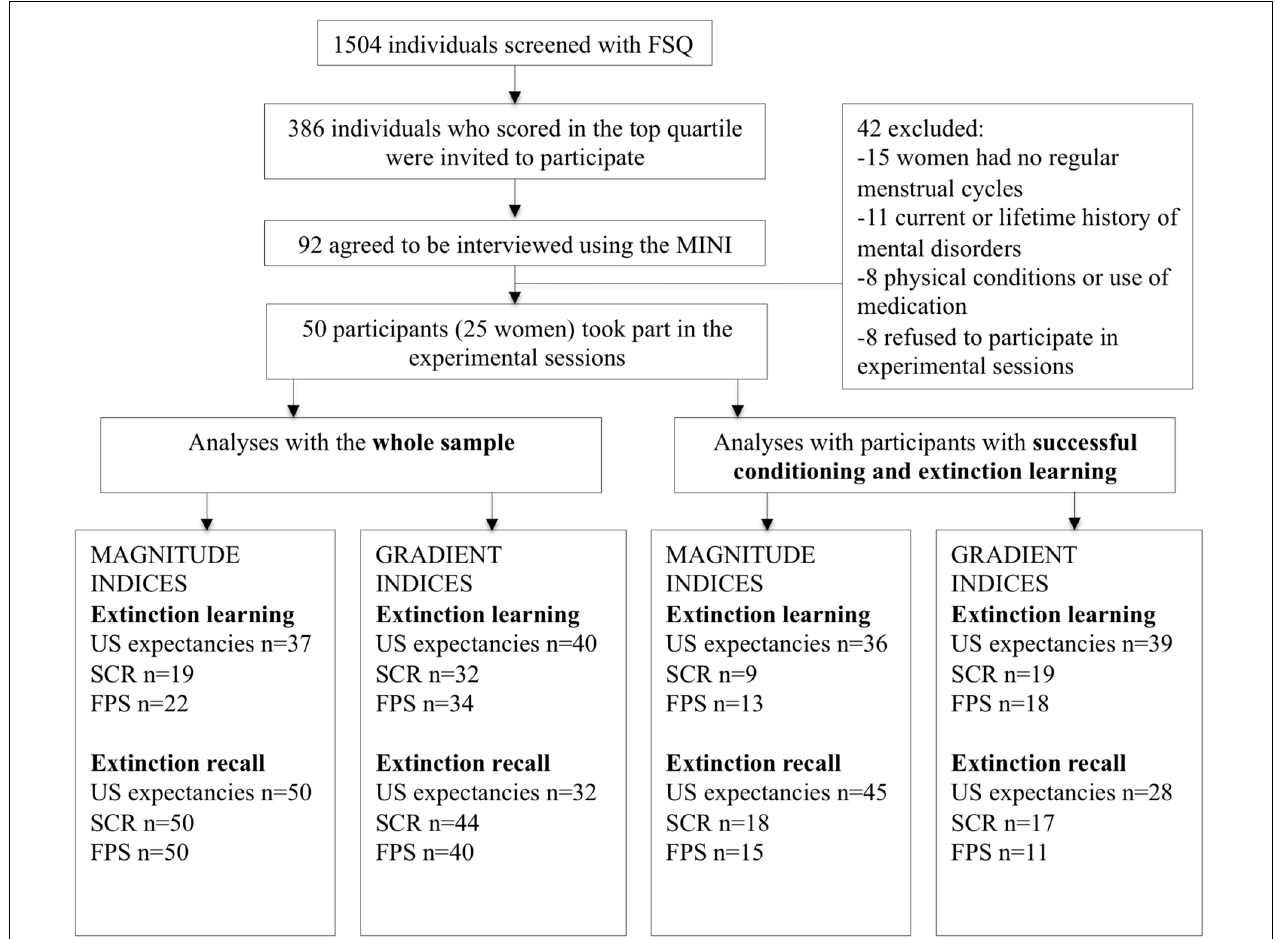
FIGURE 1 | Diagram of the sample selection procedure and participants included in each analysis. FSQ, Fear of Spiders Questionnaire; MINI, Mini International Neuropsychiatric Interview; US, Unconditioned stimulus; SCR, Skin Conductance Response; FPS, Fear-Potentiated